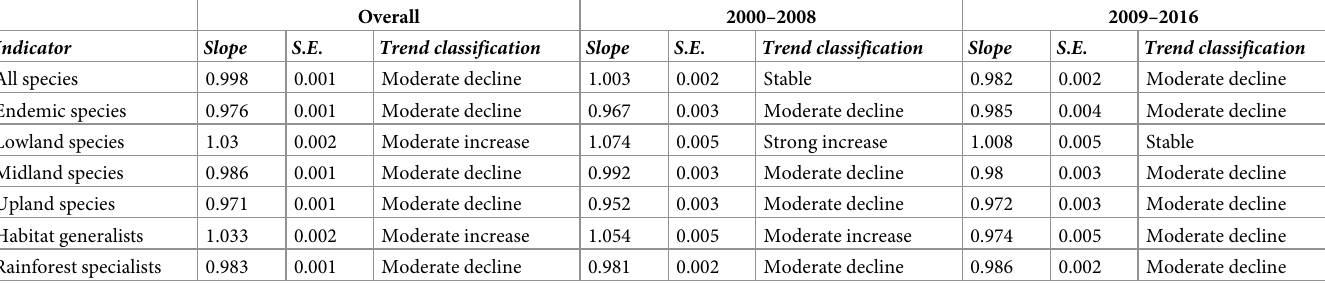
Table 1. Multi-species indicator trends between 2000–2016 (overall) and separate trends pre-2009 and